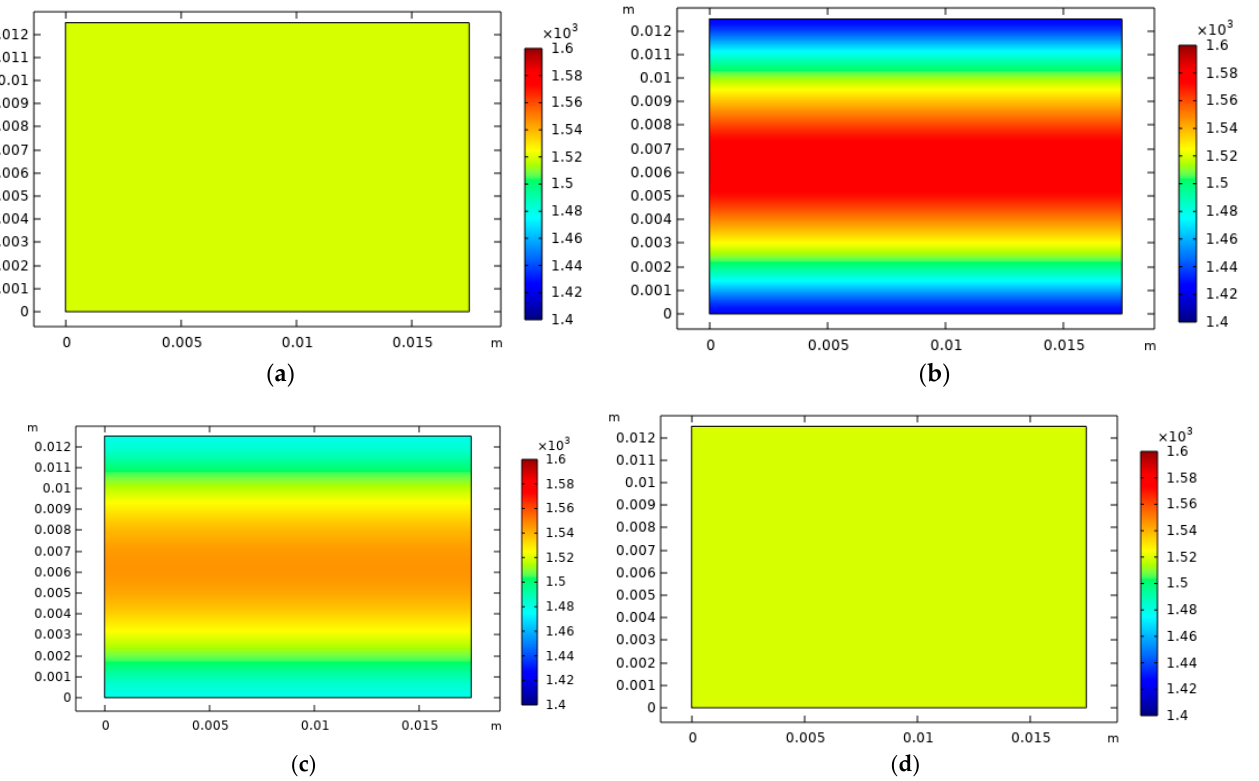
Figure 7. Dry density distribution at different times (( a ) t = 0, ( b ) t = 200 min, ( c ) t = 500 min, ( d ) t = 1200 min) (under confined volume conditions, Path AB’C’, hydration stage AB’). As can be seen in Figure 7, the dry density changes homogeneously along the